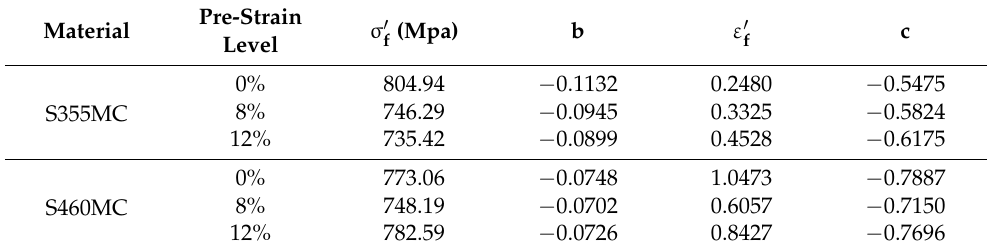
Table 4. Cyclic material